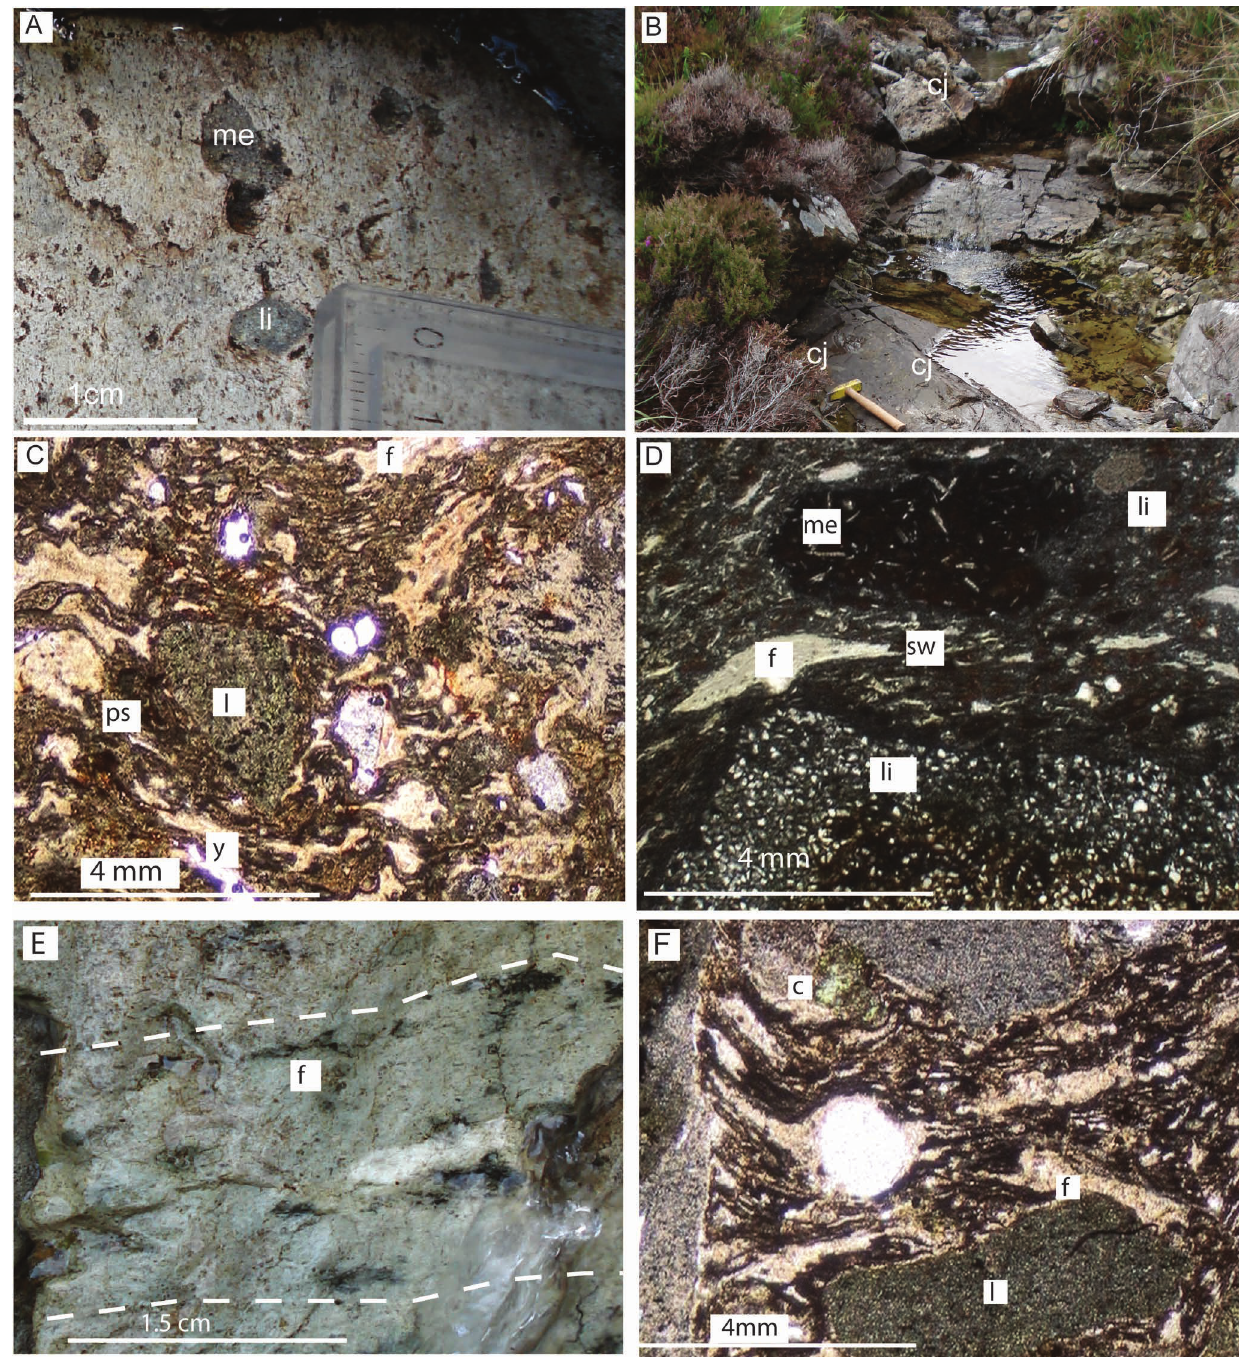
Figure 7: Field and petrographic characteristics of incipiently welded ignimbrite (mLTi) and welded ignimbrite (mLTe). [A] Type III mafic enclaves (after Troll et al. [2004]) are ubiquitous within mLTi as highly lobate clots <1.5 cm in diameter (log 16, 447 m height, see Supplementary Material 1). Lithic lapilli (li) are subrounded. [B] Near horizontally orientated columnar cooling joints (cj) in mLTi within Allt nan Suidheachan (log 16, 440 m height, see Supplementary Material 1). [C] Matrix of mLTi showing abundant undeformed-partially aligned glass shards (y). Left to right orientated fabric is deflected around a basalt lithic-lapilli (l). Much of the matrix is composed of very dark amorphous recrystallized glass. Matrix fiamme (f) are more deformed and streaked out towards top mid-page. Pressure shadows (ps) have formed around lithic lapilli (l) and within these regions fiamme are less deformed, PPL. (log 18, 292 m: Supplementary Material 1). [D] Heterolithic mLTi containing fine grained sandstone lithic lapilli (li), and fiamme (f) with swallow tail (sw) which together with external fabric has been deformed around the sandstone. A type III mafic enclave (me) with randomly orientated bytownite laths and lobate margins, also has fabric deflected around it. XP. (log 16, 445 m, Supplementary Material 1). [E] Eutaxitic fabric (white hatched lines) in mLTe orientated parallel to chloritized fiamme (f), log 14, 305 m height, Supplementary Material 1. [F] PPL image (log 16, 610 m height, see Supplementary Material 1) showing pronounced eutaxitic fabric within mLTe, chlorite (c), and fiamme (f), which have been deflected around lithic lapilli